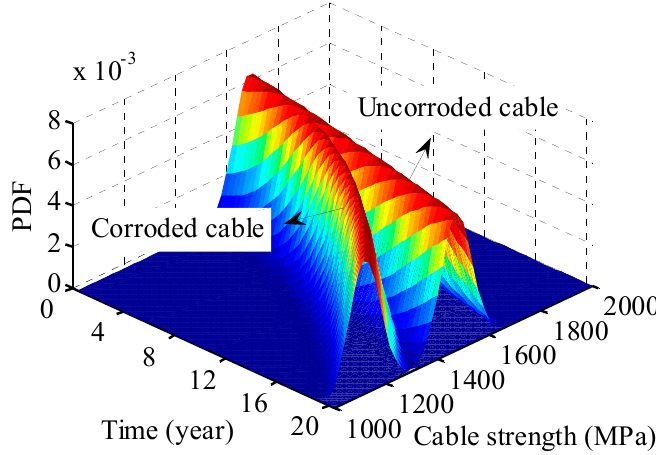
Figure 3. Degradation of the cable strength accounting for corrosion.